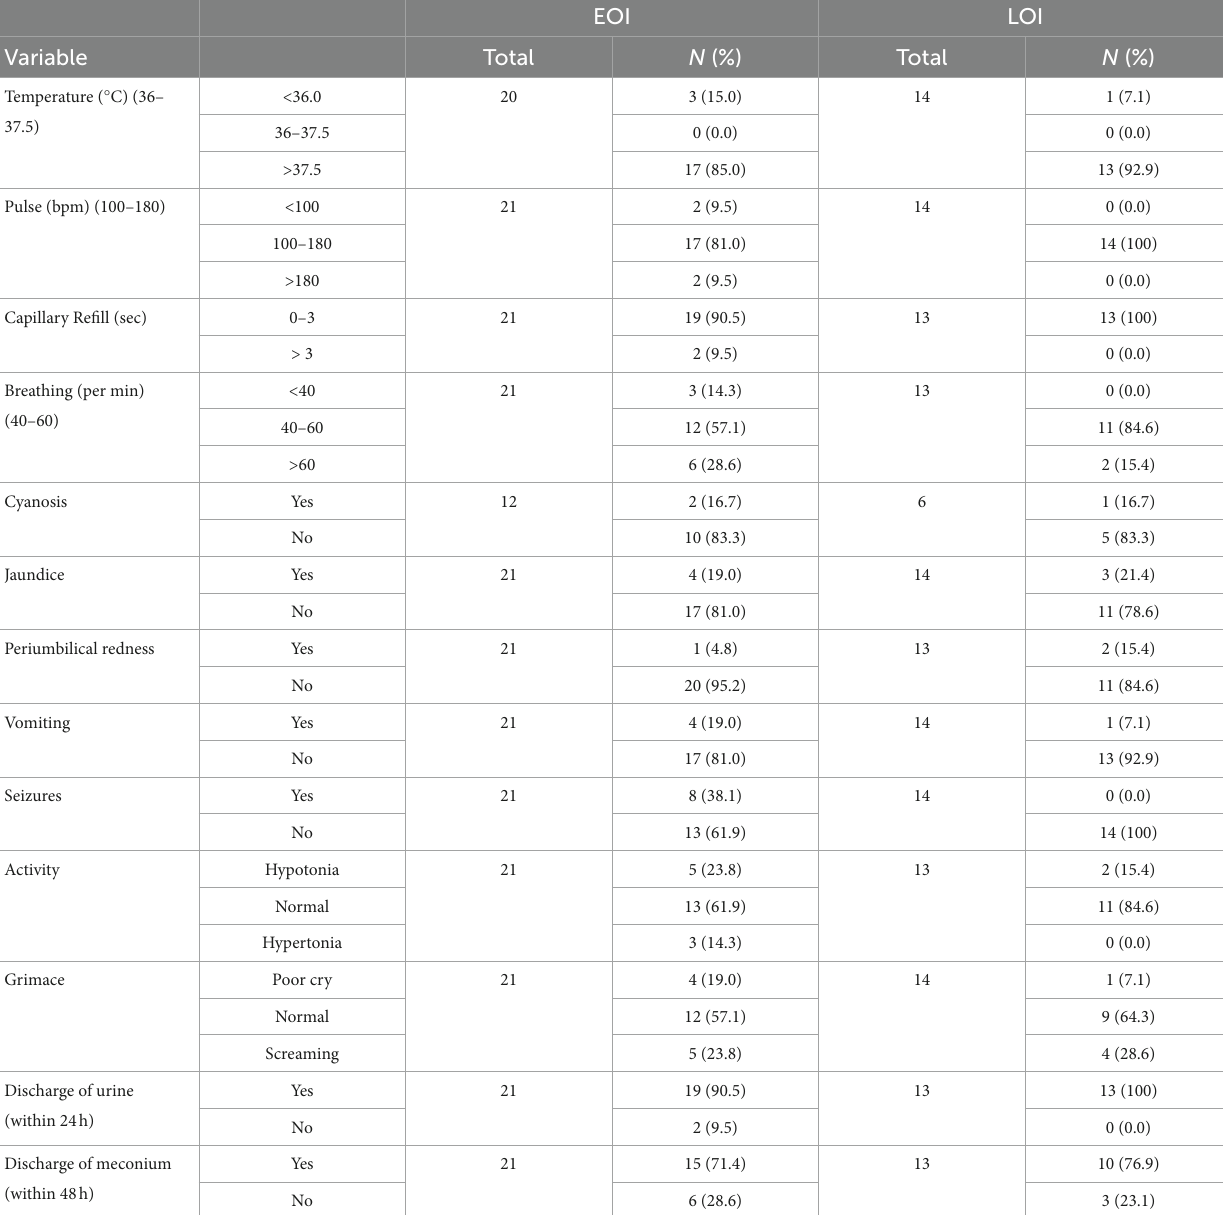
TABLE 1 Clinical aspects of sick neonates with proven and probable EOI and